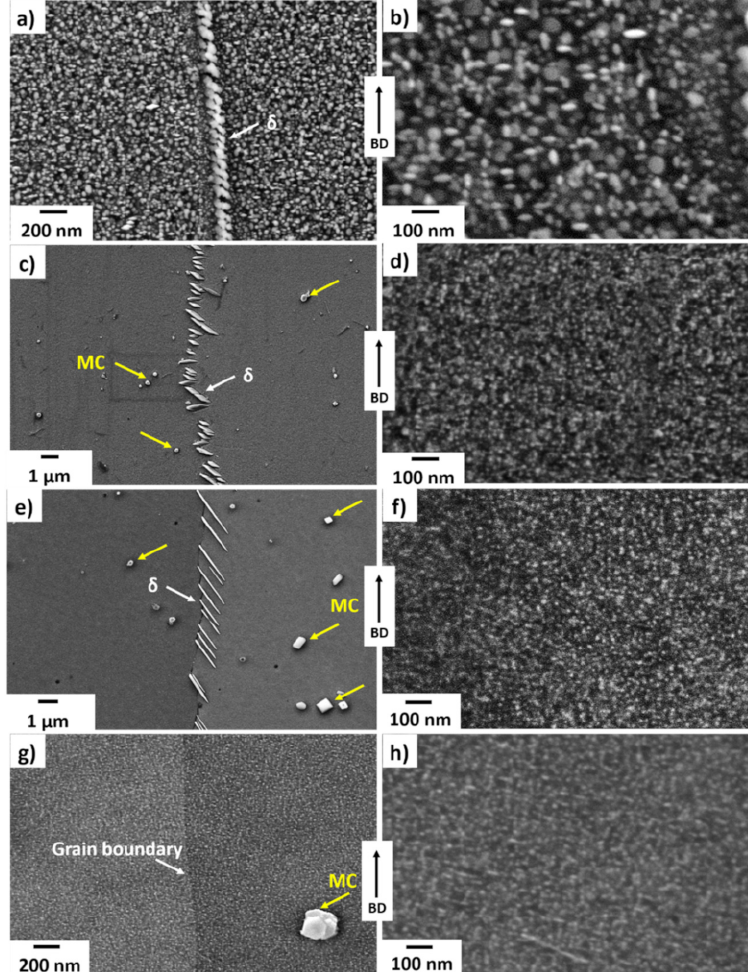
Figure 7. SEM micrographs showing grain boundary δ phase morphology and γ ’/ γ ” precipitates for various heat treatments: ( a , b ) DA, ( c , d ) SA, ( e , f ) HSA, ( g , h ) HA. The black arrows indicate the building